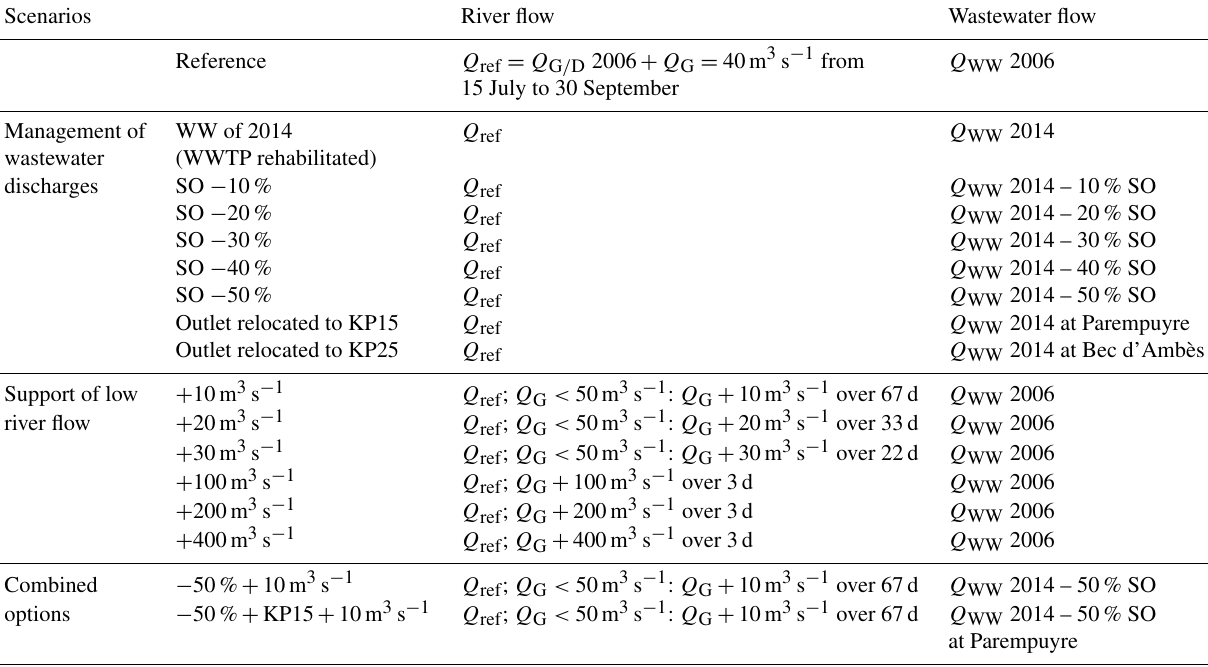
Table 1. Forcing of the different scenarios simulated with the model ( Q ref : river flow of 2006; Q G / D : river flow of Garonne and Dordogne; Q WW : wastewater flow; SO: sewage overflow).